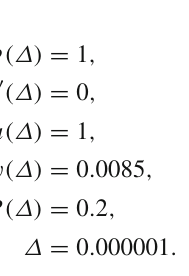
of symmetry and drastically reduces to zero at the boundary of the elastic body at the radial position r b